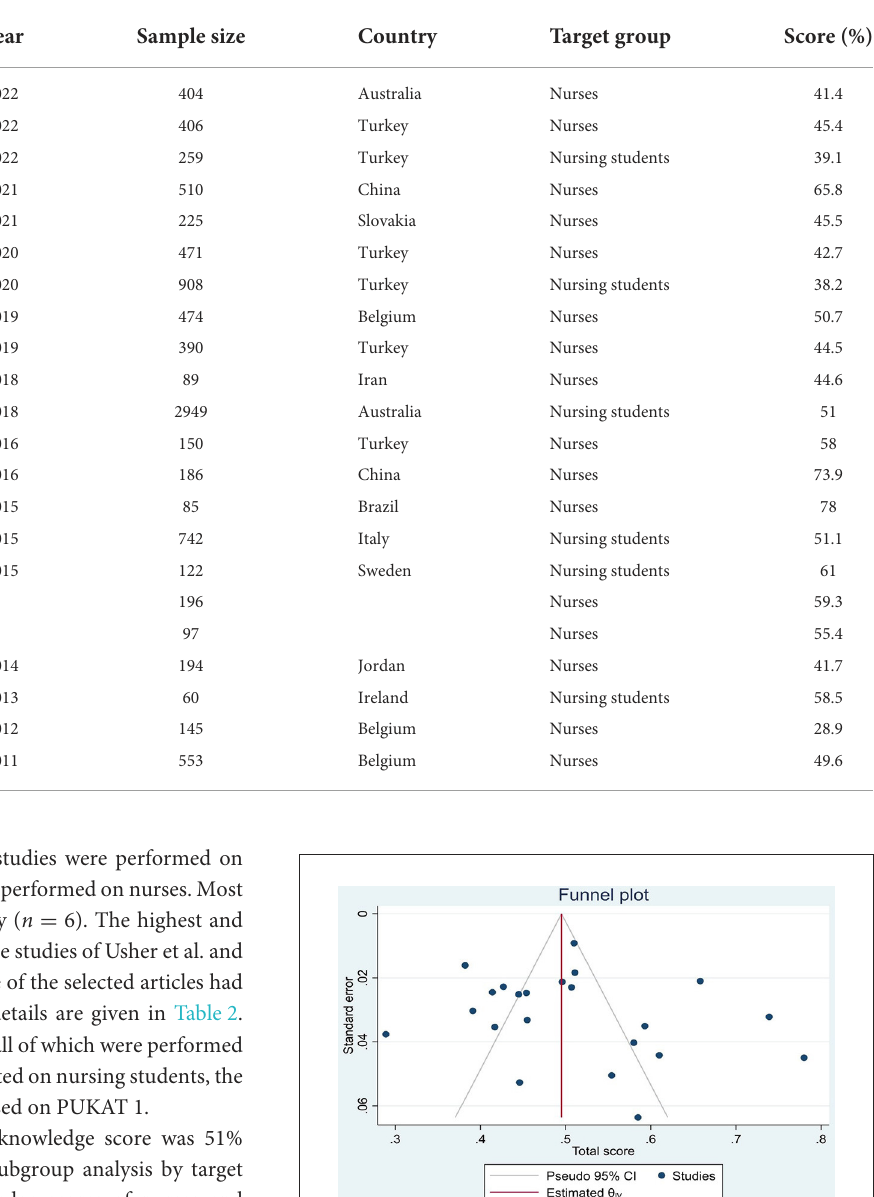
TABLE 2 The characteristics of selected studies.